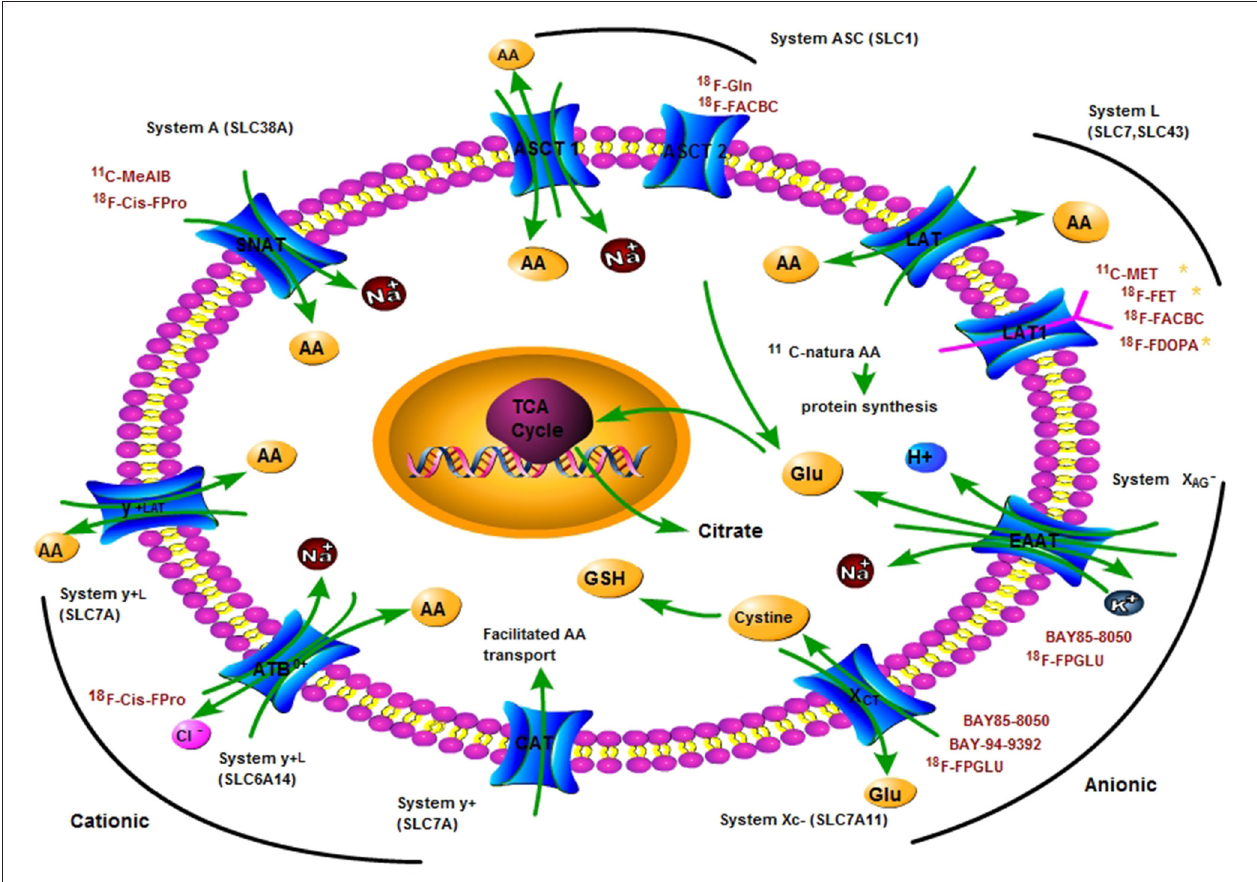
FIGURE 1 | A principle scheme of the metabolic pathways and substrates accounting for the intracellular uptake of key clinical amino acids PET tracers for imaging tumor metabolism. Positron nuclide-labeled amino acids are shown in red colored words. AA, amino acid; ASCT, L-alanine, L-serine, cysteine transporter; ASCT2, ASC-type amino acid transporter 2 (SLC1A5); Gln, glutamine; Glu, glutamate; LAT1, L-type amino acid transporter 1 (SLC7A5); SNAT, system A amino acid transporter; EAAT, Excitatory amino acid transporters; xCT, a light chain of anionic amino acid transporter system X C − (SLC7A11); TCA, tricarboxylic acid